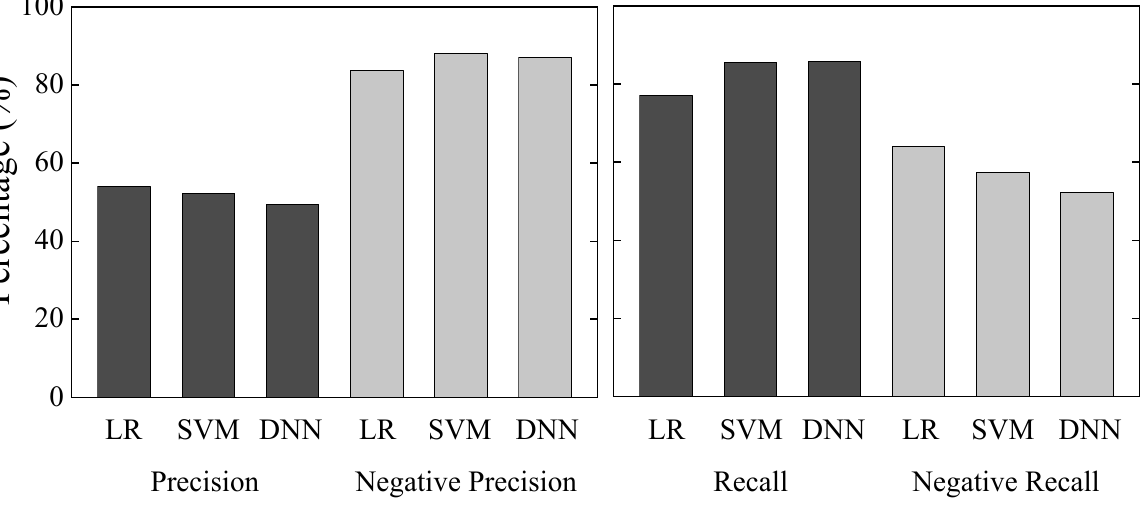
Figure 11. Comparison of Precision, Negative Precision, Recall, and Negative Recall in Section 3.8.